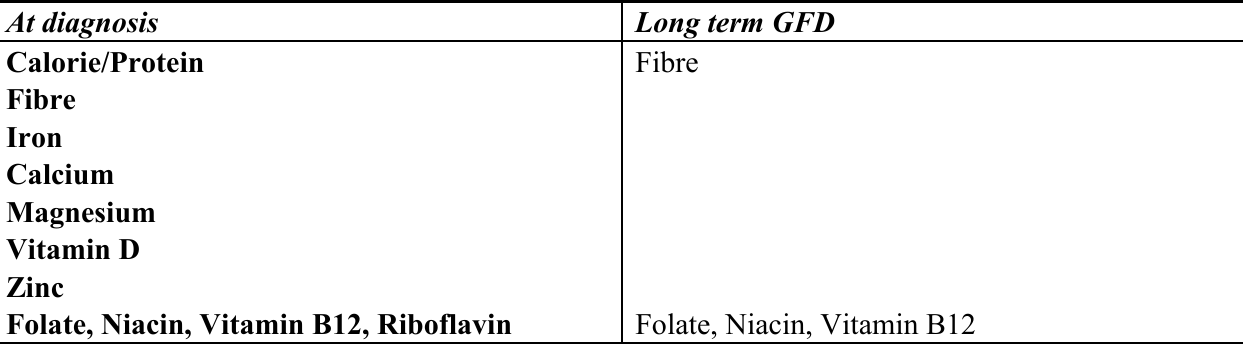
Table 1 .Common nutrient deficiencies in celiac subjects at diagnosis and after Gluten Free Diet